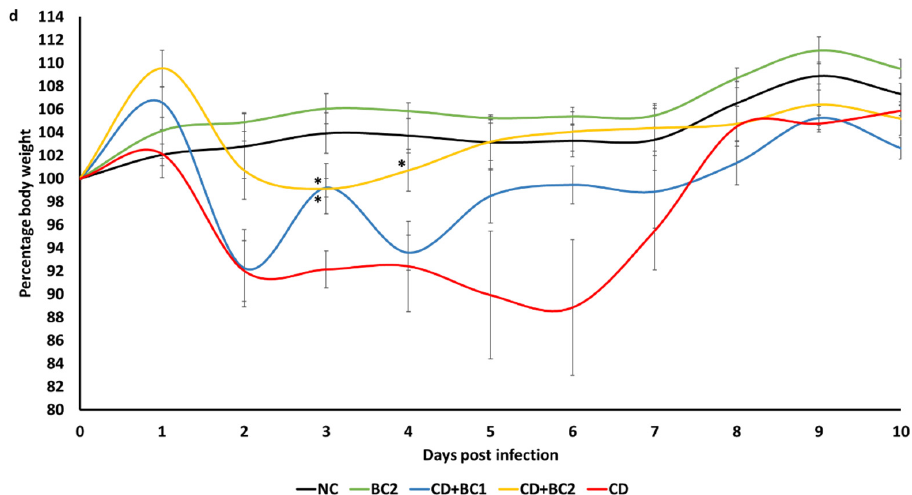
Figure 2. Effect of baicalin supplementation on clinical severity and change in body weight in mice after CDI. Average clinical scores and percentage body weights were recorded from 1 DPI to 10 DPI for the different treatment groups in the prophylactic BC study ( a , c ) and therapeutic BC study ( b , d ). **, * indicates a statistically significant difference ( p < 0.001, p < 0.05, respectively) relative to the untreated challenge group (CD); † symbol indicates a statistically significant difference ( p < 0.05) relative to CD+PBS. Percentage body weights among treatment groups (in (c,d) were compared within the same day time point. Error bars represent SEM. Treatment groups: NC (unchallenged negative control), Ant (unchallenged antibiotic control), Ant+BC (unchallenged antibiotic + 22 mg/L BC control), BC2 (unchallenged 22 mg/L BC control), CD (Ant+ C. difficile -challenged control), CD+PBS (Ant+ C. difficile -challenged control, PBS solvent control), CD+BC1 (Ant+CD + 11 mg/L BC), CD+BC2 (Ant+CD + 22 mg/L